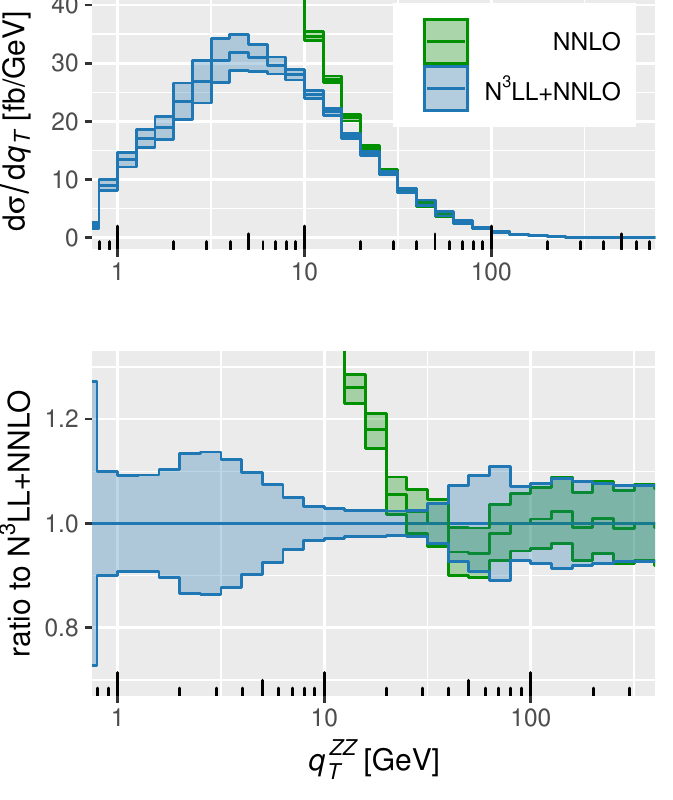
Figure 10 . The q WH